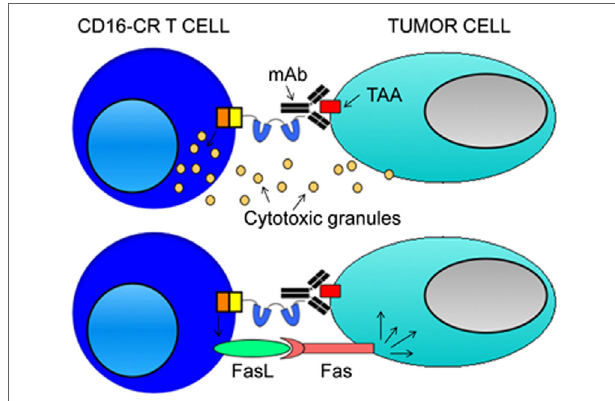
FiguRe 3 | Mechanisms of CD16-CR T cell-mediated tumor cell elimination . CD16-CR T cells acquire the specificity of a monoclonal antibody (mAb) recognizing a tumor-associated antigen (TAA) on the cell surface of tumor cells through the binding of the CD16 with the mAb Fc fragment leading to the activation of T cell-mediated cytotoxicity. In this context, engineered T cells kill tumor cells by using two mechanisms. The first involves the activation of T cell killing machinery by the release of cytotoxic granules (upper panel). The second arises from the induction of CD16-CR dependent FAS expression on the cell surface of tumor cells that allows FAS ligand positive-engineered T cells to kill tumor cells by a granule independent cellular cytotoxicity (lower panel). However, the latter mechanism is just a hypothetical model based on a single study employing transformed MD45 mouse T cells. Then, the confirmation of the existence of a role for granule independent cytotoxicity requires additional